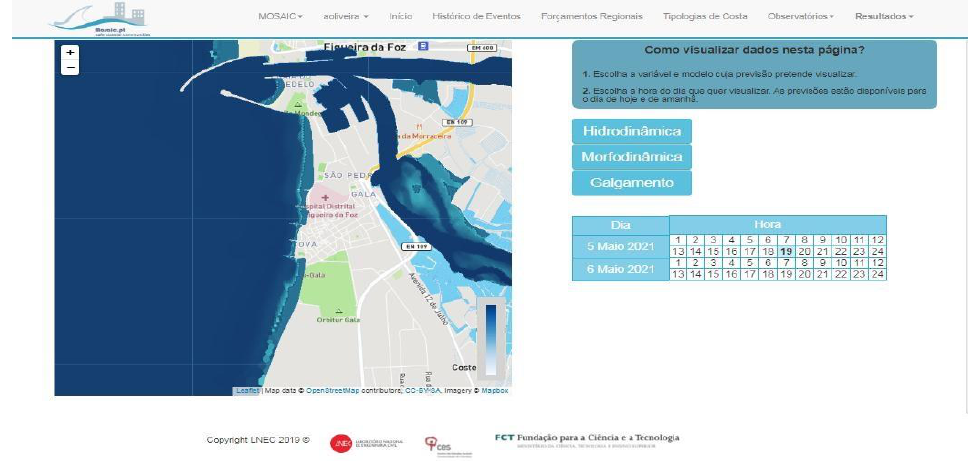
Figure 12. Sample water elevation layer for the SCHISM prediction at the Cova-Gala observatory. The dark blue box provides instructions on how to select the model, variable and date.